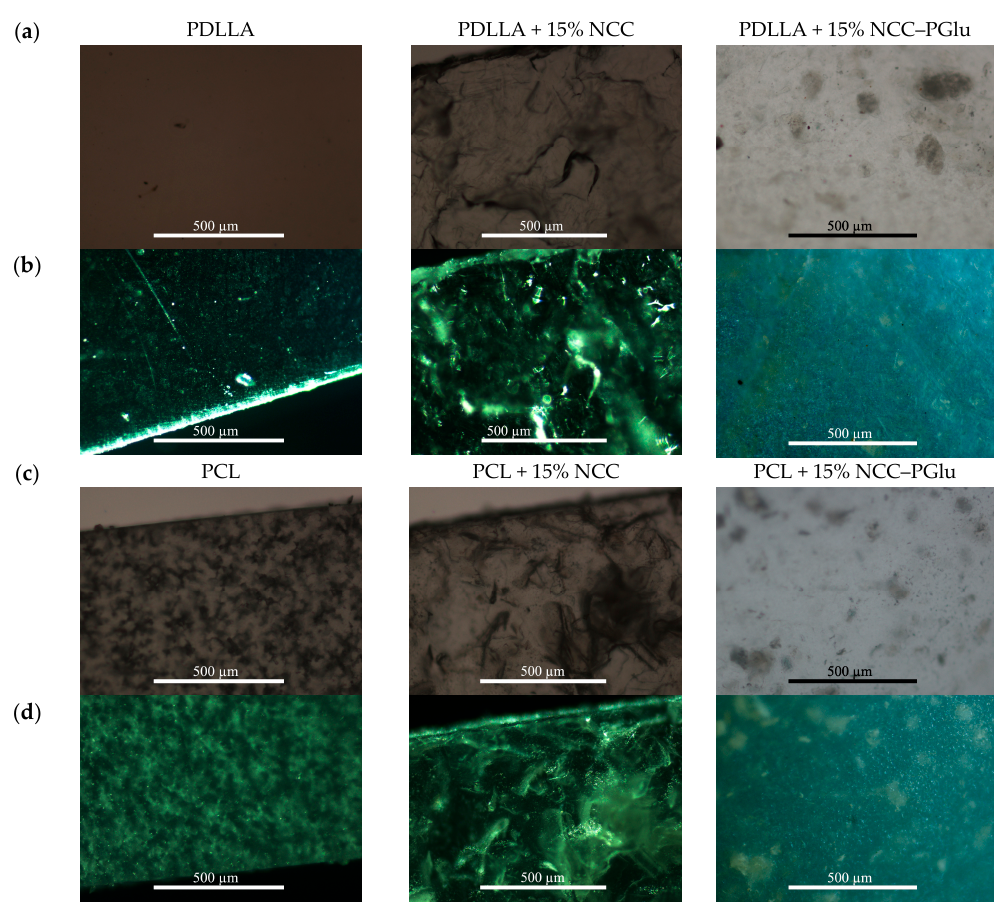
Figure 4. Optical transmitted light ( a , c ) and reflected ( b , d ) microscopy images registered for pure PDLLA and PCL and their composites with neat and modified NCC (10 × ). Surface topography of the prepared materials was evaluated by AFM (Figure 5). For the PDLLA, PDLLA + 15% NCC, and PDLLA + 15% NCC–PGlu specimens, the average heights were 1.3 μ m, 2.3 μ m, and 1.5 μ m, respectively. In turn, the average heights for PCL, PCL + 15% NCC, and PCL + 15% NCC–PGlu specimens were found to be 0.5 μ m, 2.5 μ m, and 1.8 μ m, respectively.